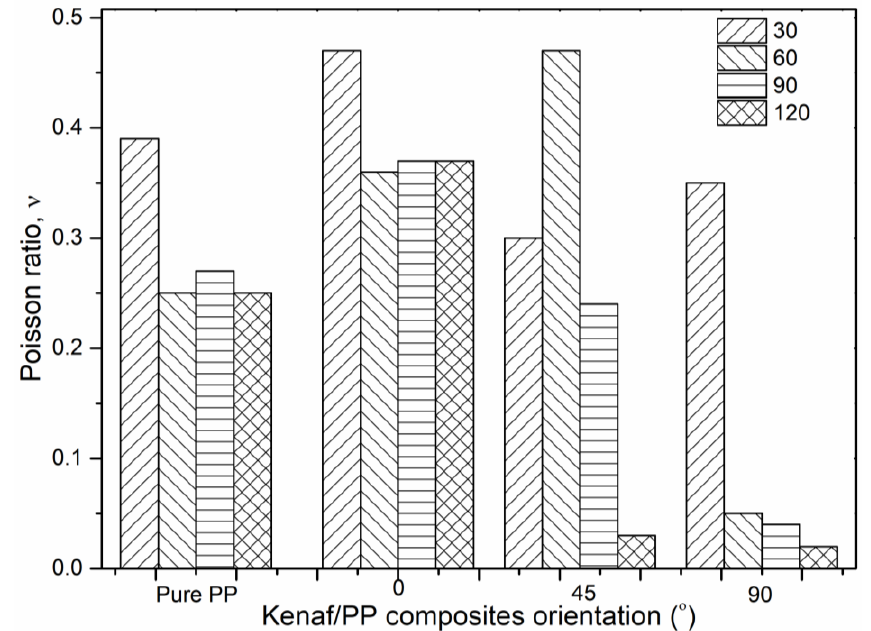
Figure 8. Poisson’s ratio results of kenaf/polypropylene (PP) composites at various temperatures and orientation angles.